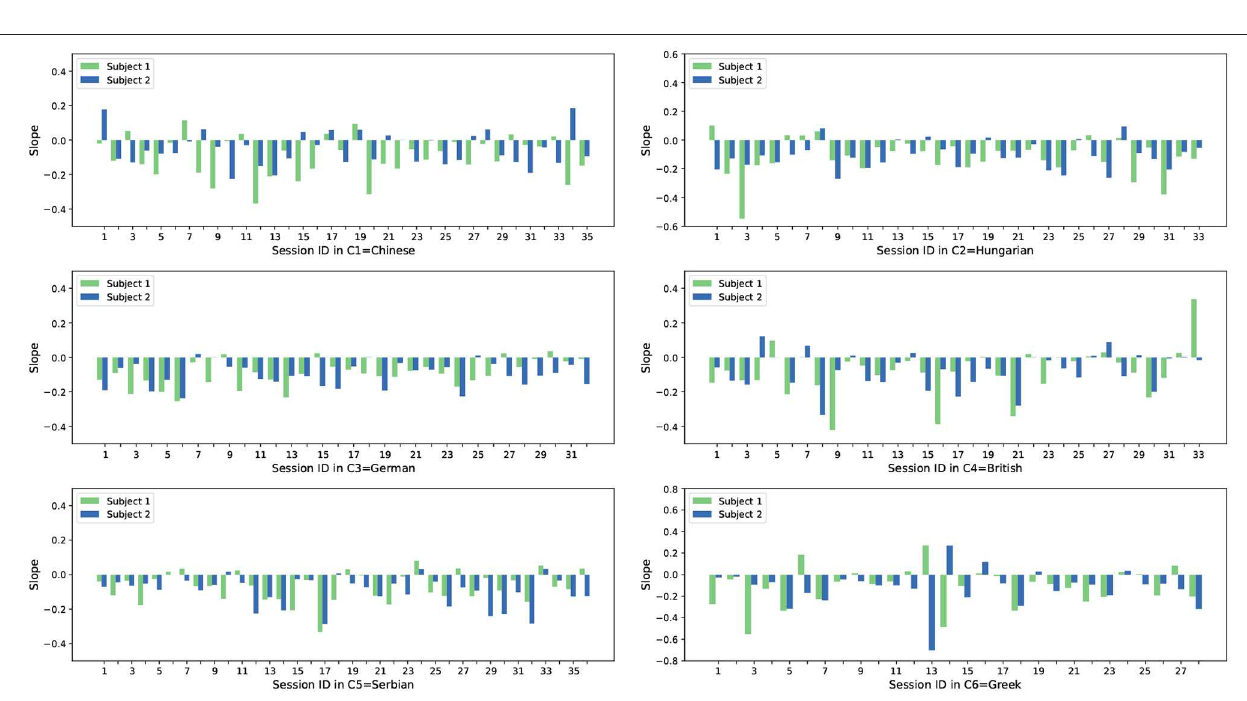
FIGURE 4 | Slope of RMSE sequences of paired subjects from all recordings in all six cultures. The results are calculated based on the acoustic